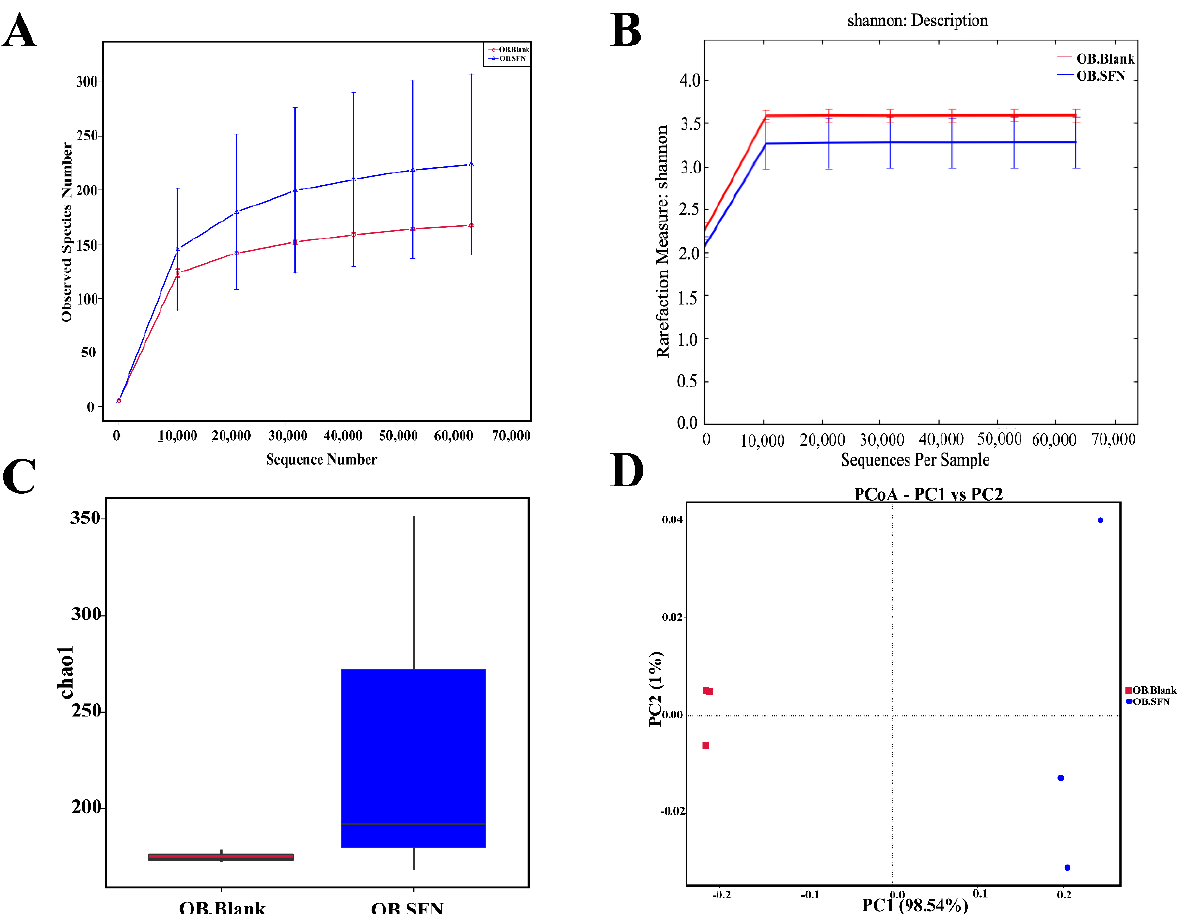
Figure 5. The effect of sulforaphane (SFN) on the microbial community of obese patients at 24 h of fermentation. ( A ) Rarefaction curve of the sample; ( B ) Shannon curve of the sample; ( C ) Chao1: total number of bacterial species; ( D ) principal component analysis (PCA) plot.